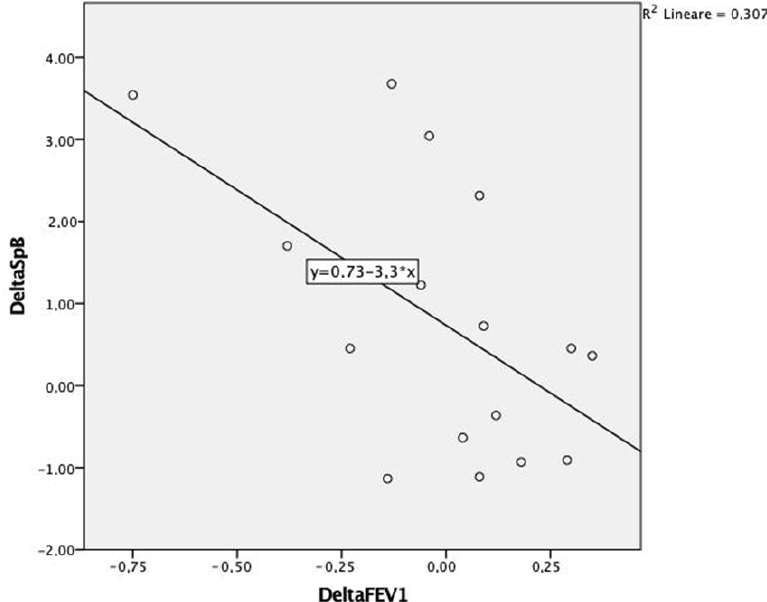
Figure 2. Correlation between delta FEV1 and delta SP-B over the 12-month period (Pearson − 0.5; p < 0.02).